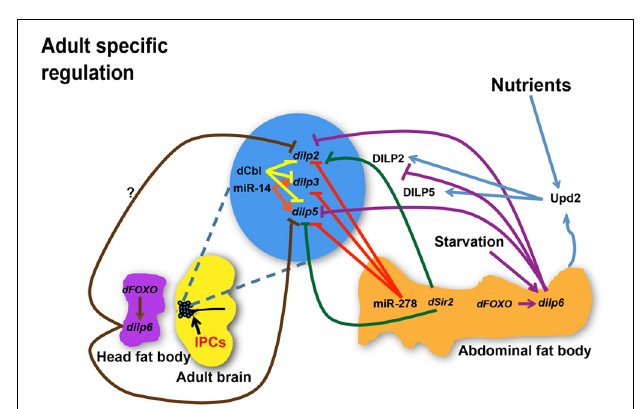
FIGURE 2 | Regulation of dilp expression and circulating DILP levels in response to nutrient status, micro RNAs (miRNAs), and transcriptional factors during adulthood. miR-278 down-regulates dilps expressed in the IPCs while miR-14 positively regulates dilp3 and dilp5 expression. dCbl in the IPCs down-regulates dilps 2, 3, and 5 . dSir2 in the fat body represses expression of dilp2 and dilp5 . dFOXO acts through dilp6 in the abdominal fat body to repress dilp2 while it is not known if dFOXO in the head fat body regulates dilp2 through a similar mechanism. dilp6 in abdominal or head fat body tissues negatively regulates dilp2 and dilp5. While dilp6 only impairs hemolymph DILP2 levels, Upd2 senses the fed state and induces secretion of DILP2 and DILP5. dilps, genes encoding Drosophila insulin-like peptides; DILPs, Drosophila insulin-like peptides; IPCs, Insulin-like peptide producing cells; dCbl, a member of E3 ubiquitin ligases and adaptor proteins; dSir2 , a histone deacetylase. Arrows indicate positive regulation whereas blunt-ended lines indicate negative